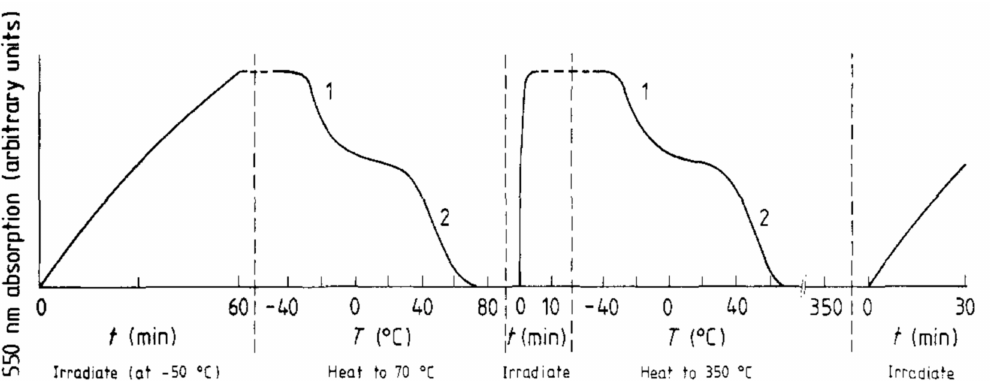
Figure 3. Irradiation and temperature annealing behavior of the 540 nm band for high-energy electron irradiation at − 50 ◦ C (Reprinted with permission from [53]. Copyright 2021 IOP